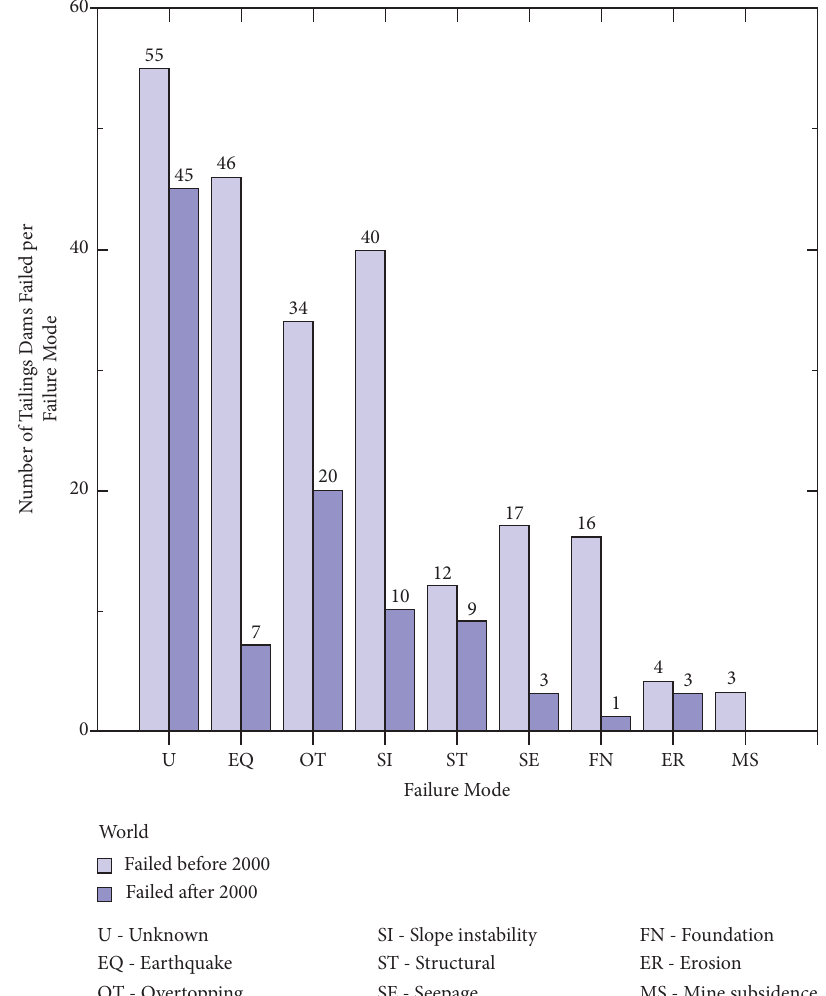
Figure 12: Number of tailings failed per failure mode in the world, before and after 2000 (data from Bowker [22] and Torrez-Cruz